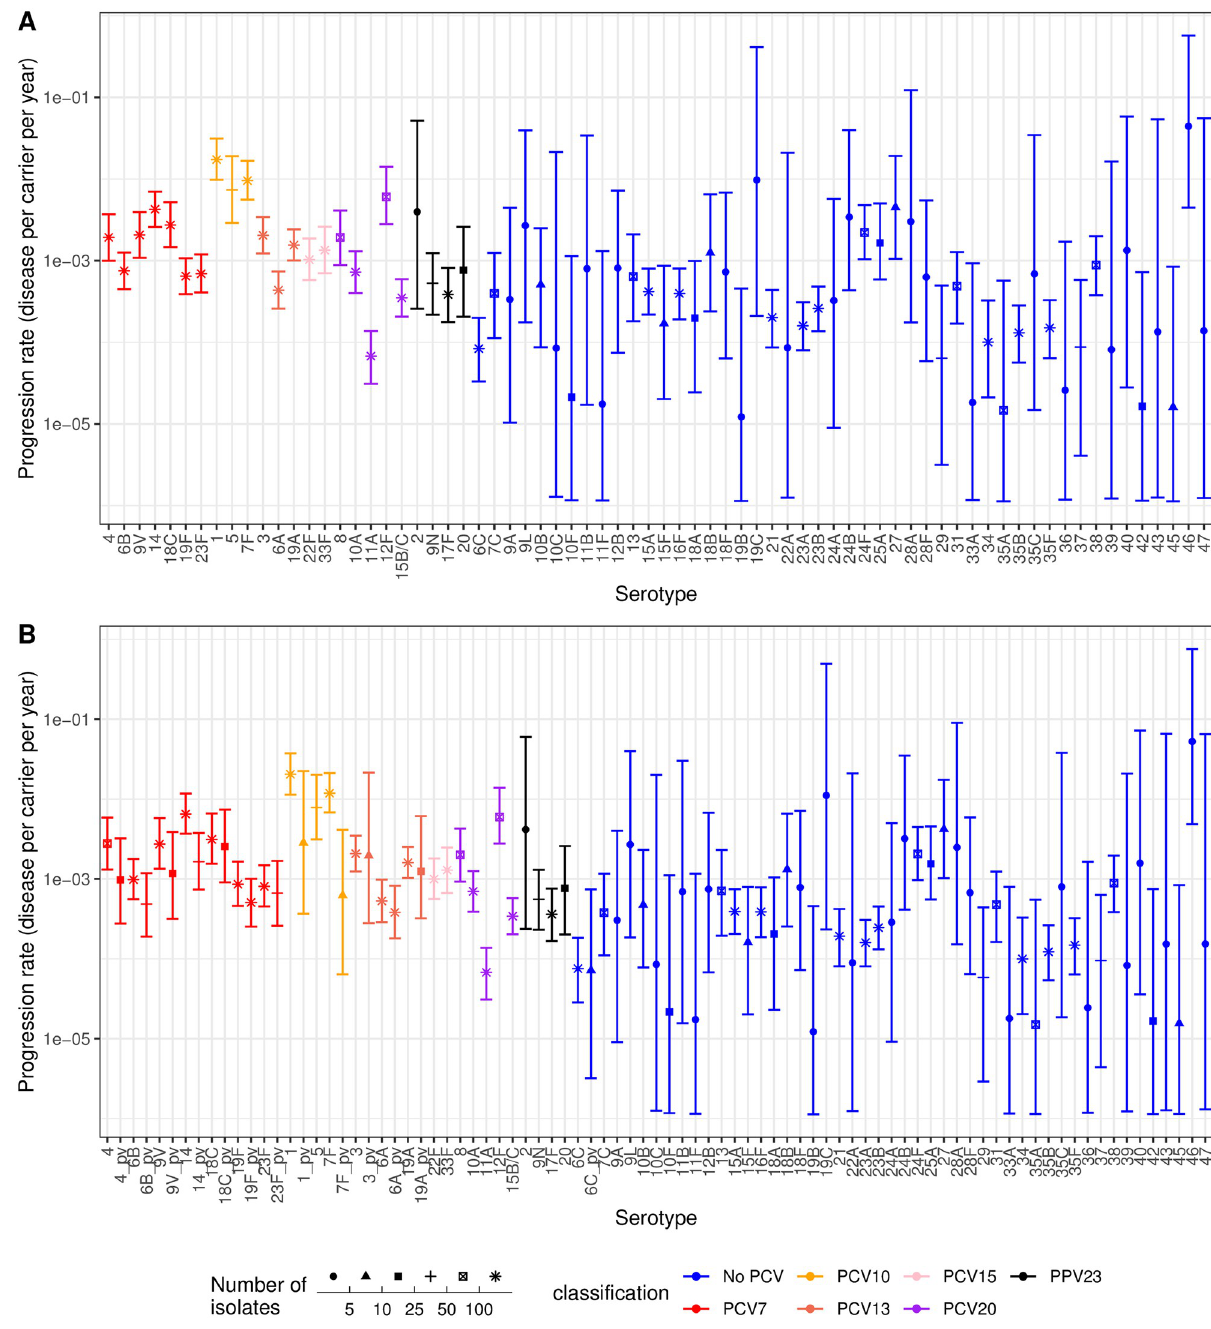
Fig 2. Invasiveness estimates for S . pneumoniae serotypes from the study-adjusted type-specific negative binomial model applied to the full dataset of serotype studies from child carriage and disease. Points represent the median estimate, and are coloured according to the vaccine formulation in which they are found; all higher valency formulations encompass the serotypes found in lower valency formulations, with the exception of 6A not being present in PPV23. The point shape represents the sample size, summed across disease and carriage isolates from all studies, on which the estimates are based. The error bars show the 95% credibility intervals. (A) Estimates for all 72 serotypes in the full dataset. (B) Estimates when distinguishing between vaccine-type serotypes in unvaccinated and vaccinated populations. Vaccine serotypes in vaccinated populations are denoted with the suffix